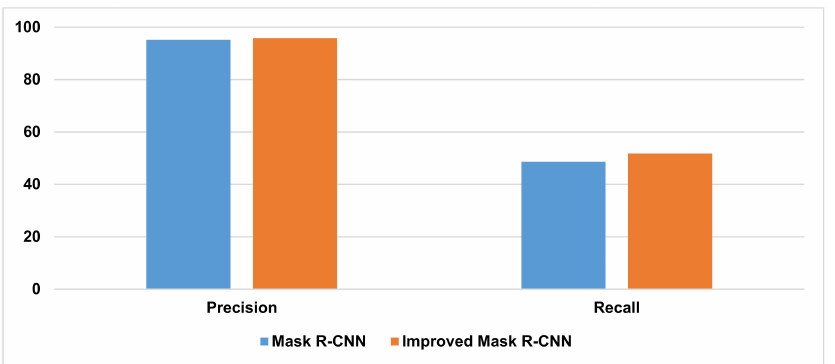
Figure 11. Results of precision and recall for the testing dataset for default and improved Mask R-CNN.